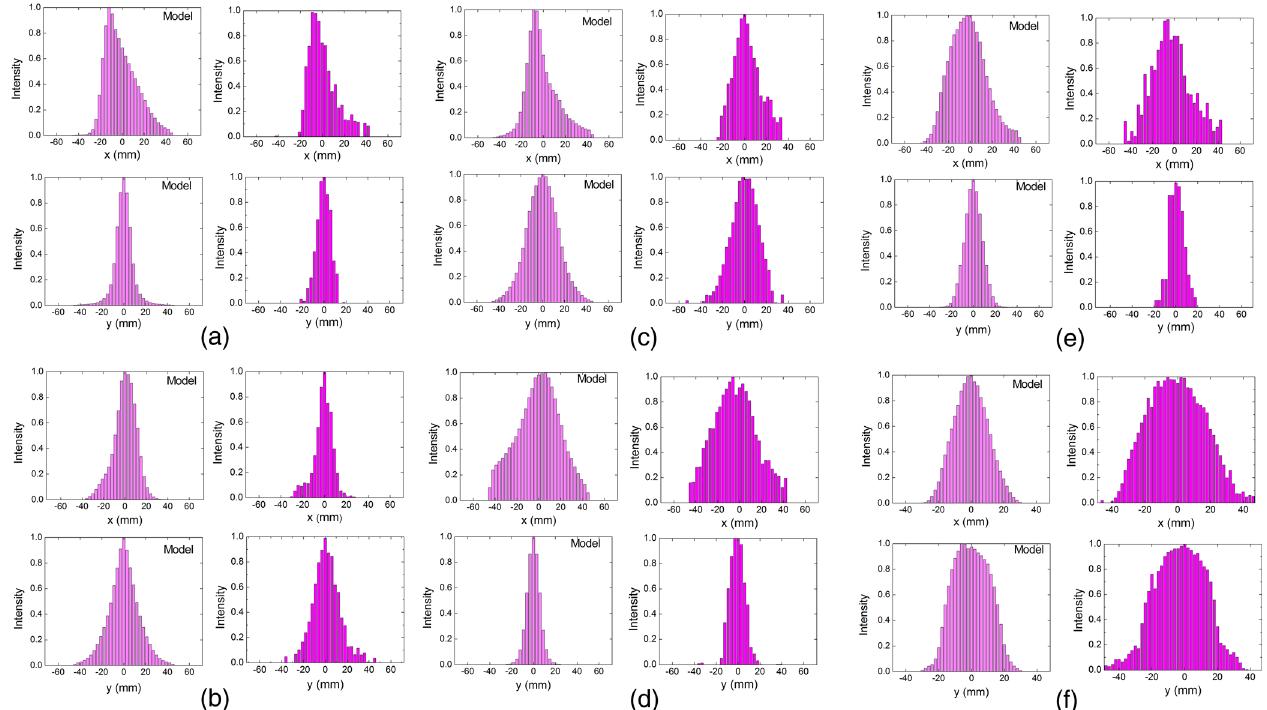
FIG. 7. Transverse beam profiles at different instrumentation locations along the M2 and M3 lines. (a) At SEM804. (b) At SEM810. (c) At SEM706. (d) At SEM711. (e) At SEM726. (f) At PWC744. Note that, in all subfigures, the top and second rows show the horizontal and vertical profiles, respectively. Furthermore, the first column shows the simulated profile, while the second column shows the measured